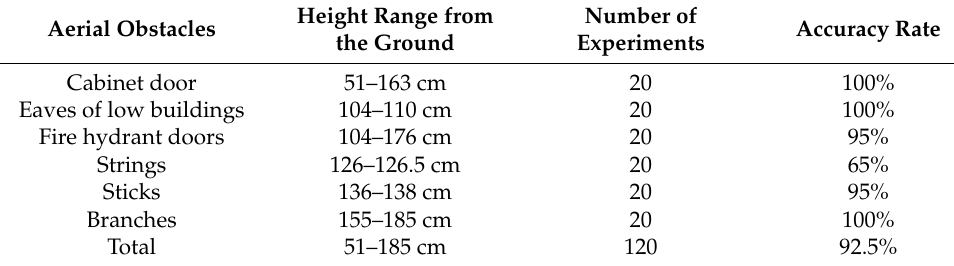
Table 1. Accuracy rate of aerial obstacle detection.